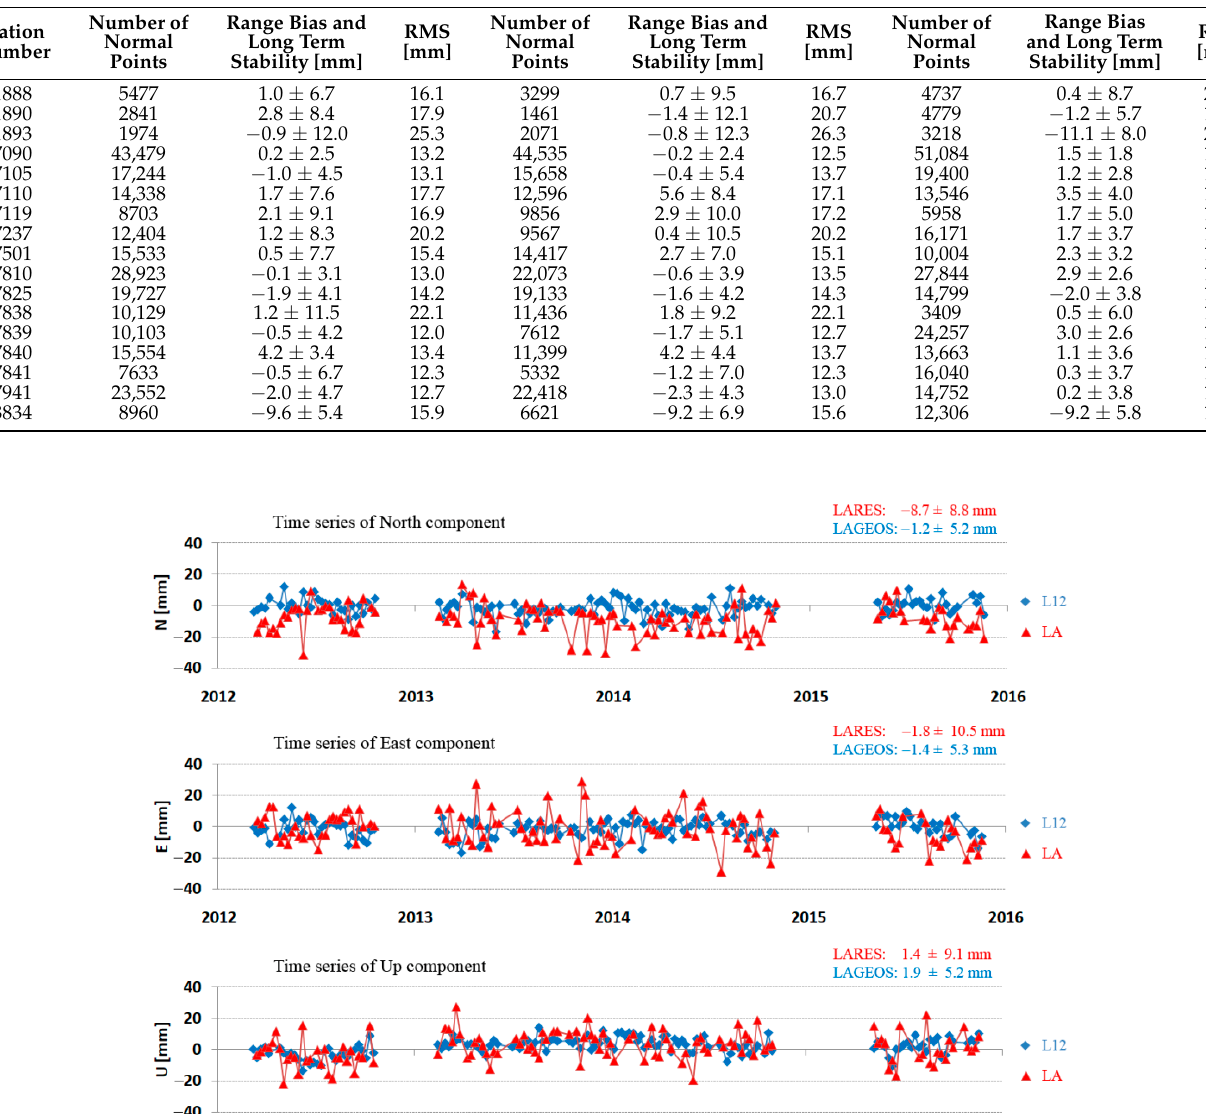
Table 5. The average Range Bias, long-term stability, and orbital RMS for SLR stations. LAGEOS-2